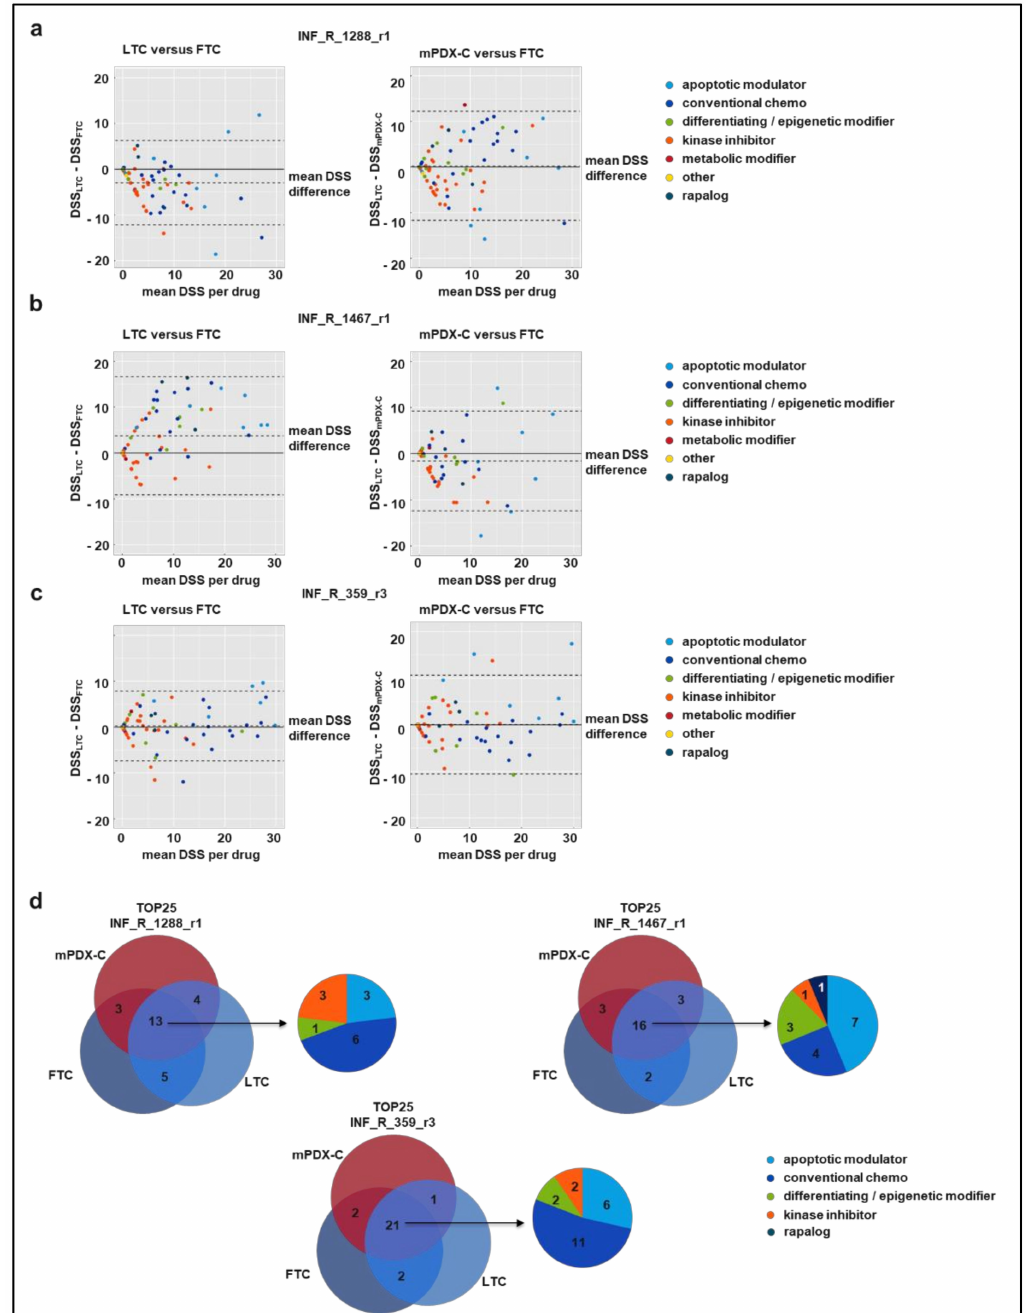
Figure 2. DSP comparison. ( a – c ) Bland-Altman plots for comparison of DSS scores of each drug for LTC (left panel, a – c ) or mPDX-C (right panel, a – c ) versus FTC. The difference between the DSS is plotted ( y -axis) against the average (mean) DSS for each drug. Color code on the right reflects the different drug classes. Cultures were derived from patient sample INF_R_1288_r1 ( a ), INF_R_1467_r1 ( b ) and INF_R_359_r3 ( c ). ( d ) Venn diagrams show the overlap of TOP25 drugs throughout all three culturing methods for each of the samples, as well as the broad classes these drugs belong to. DSS: Drugs Sensitivity Score; LTC: long-term culture; mPDX-C: mouse-PDX-derived culture; FTC: fresh tissue-derived culture. CI: confidence